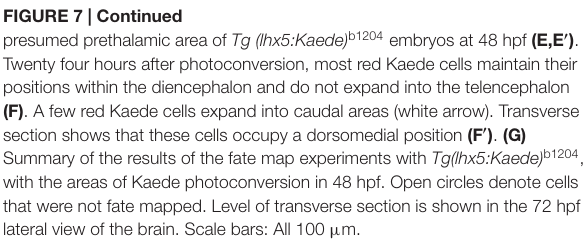
Frontiers in Neural Circuits |